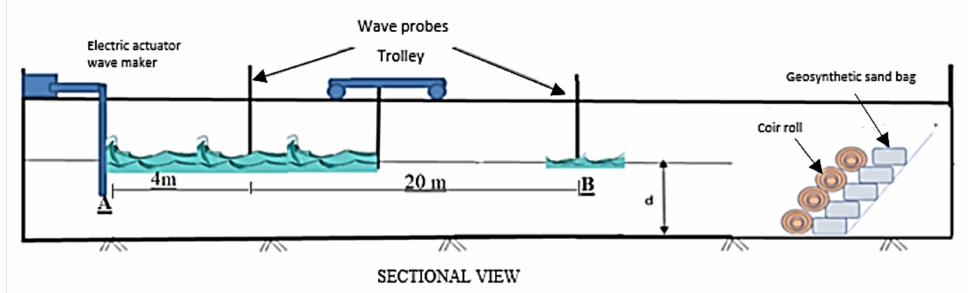
Figure 4. Schematic sketch of test setup in the wave